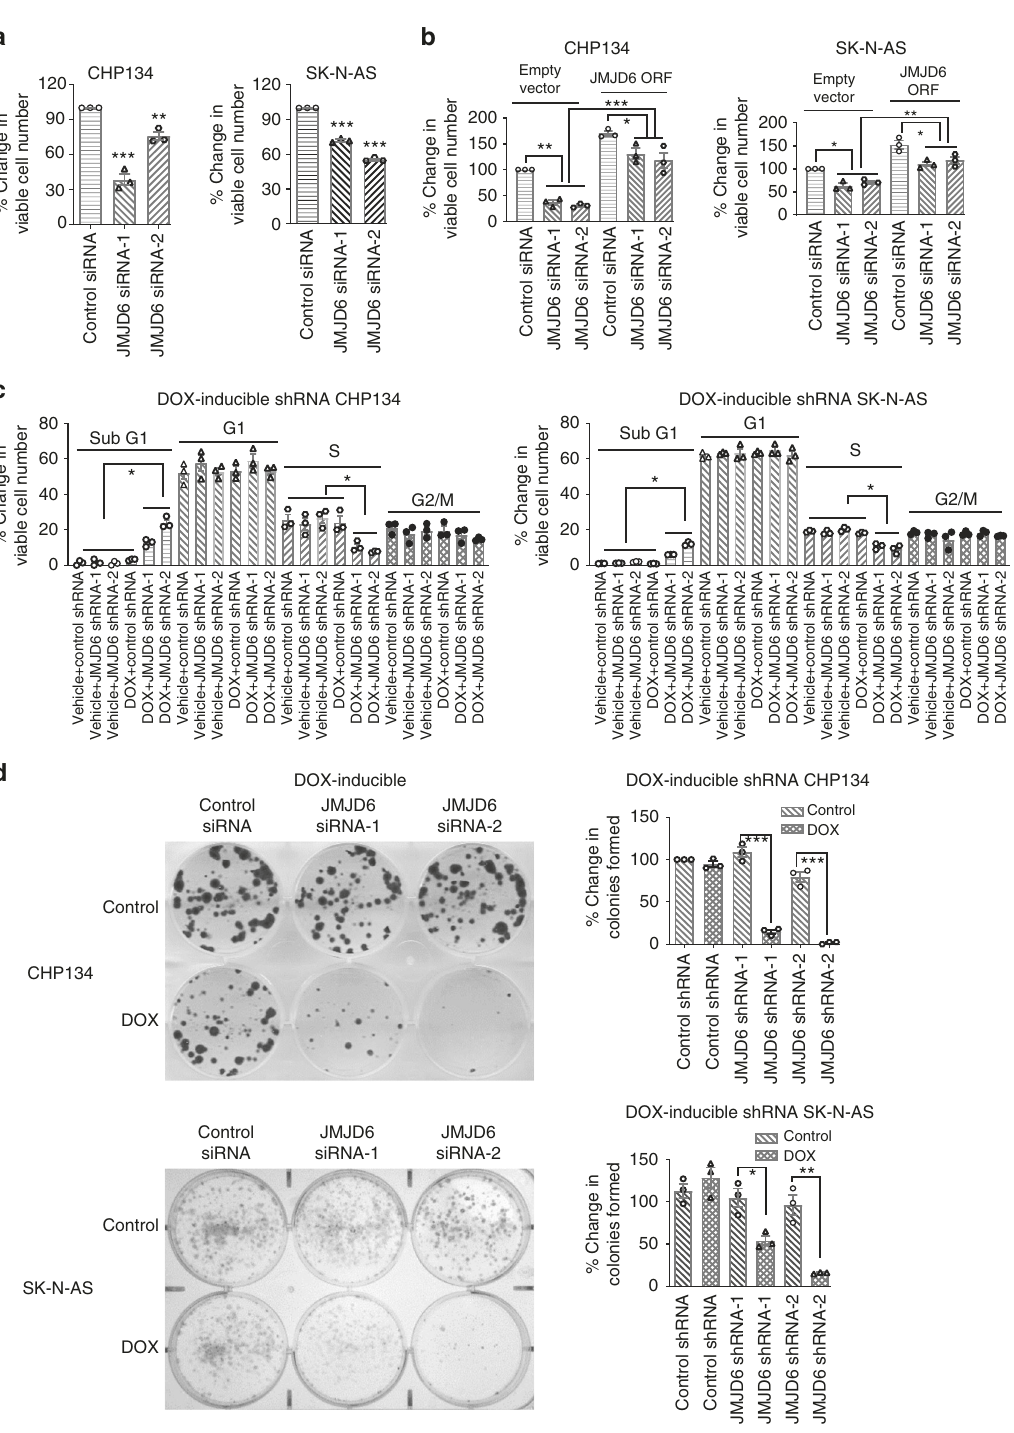
Fig. 4 JMJD6 is important for neuroblastoma cell proliferation, survival, and colony formation. a CHP134 and SK-N-AS cells were transfected with control siRNA, JMJD6 siRNA-1 or JMJD6 siRNA-2 for 96 h, followed by Alamar blue assays. Error bars represent normalized standard errors from three independent experiments (** p < 0.01, *** p < 0.001, one-way ANOVA). b CHP134 and SK-N-AS cells stably transfected with an empty vector or JMJD6 open reading frame (ORF) expression construct were transfected with control siRNA, JMJD6 siRNA-1 or JMJD6 siRNA-2, followed by Alamar blue assays. Error bars represent normalized standard errors from three independent experiments (* p < 0.05, ** p < 0.01, *** p < 0.001, one-way ANOVA). c DOX- inducible control shRNA, JMJD6 shRNA-1 or JMJD6 shRNA-2 CHP134, and SK-N-AS cells were treated with control or DOX for 72 h, followed by staining with propidium iodide and fl ow cytometry analysis of the cell cycle. The percentage of cells at each phase of the cell cycle was calculated. Error bars represent standard errors from three independent experiments (* p < 0.05, two-tailed unpaired Student ’ s t test). d DOX-inducible control shRNA, JMJD6 shRNA-1 or JMJD6 shRNA-2 CHP134, and SK-N-AS cells were treated with vehicle control or DOX for 14 days. Tumor cells were stained with crystal violet and the numbers of colonies were counted. Error bars represent normalized standard errors from three independent experiments (* p < 0.05, ** p < 0.01, *** p < 0.001, two-tailed unpaired Student ’ s t test). Source data are provided as a Source Data fi